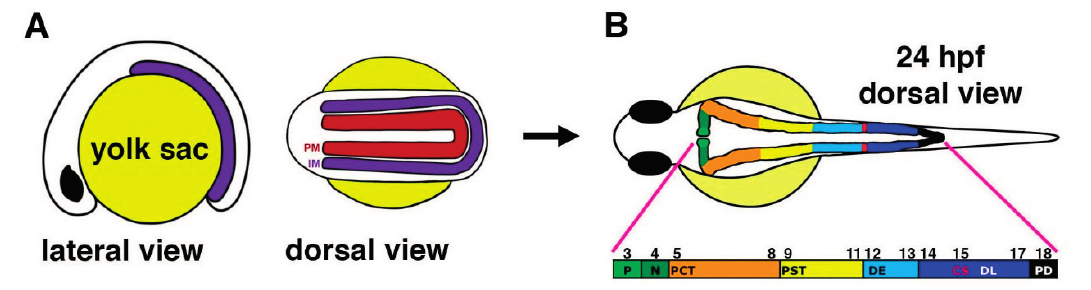
Figure 1. Anatomy of the zebrafish pronephros. ( A ) The zebrafish pronephros develops from bilateral fields of renal progenitors (purple) that emerge from the intermediate mesoderm (IM) and are located lateral to the paraxial mesoderm (PM, red) that gives rise to the somites (denoted by their number along the embryo axis respective to each nephron segment in panel B); ( B ) At 24 hours post fertilization (hpf), the two nephrons have formed and consist of a series of segments that include: podocytes (P, light green) that contribute to the blood filter, neck (N, dark green), proximal convoluted tubule (PCT, orange), proximal straight tubule (PST, yellow), distal early (DE, sky blue), corpuscles of Stannius (CS, red), distal late (DL, dark blue), and pronephric duct (PD, black). The numbers indicate the position of each nephron segment with respect to the somites. [Figure adapted from [45], through terms of the Creative Commons License of the